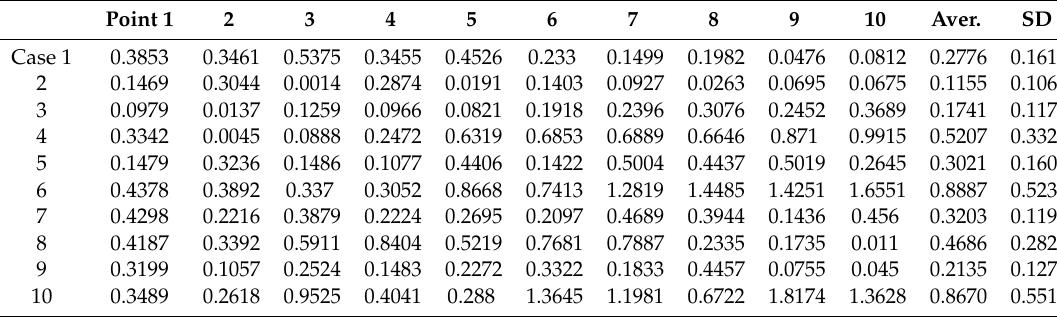
Table 3. The displacement of the measurements at 10 randomly distributed points on the 3D printed BGS-7